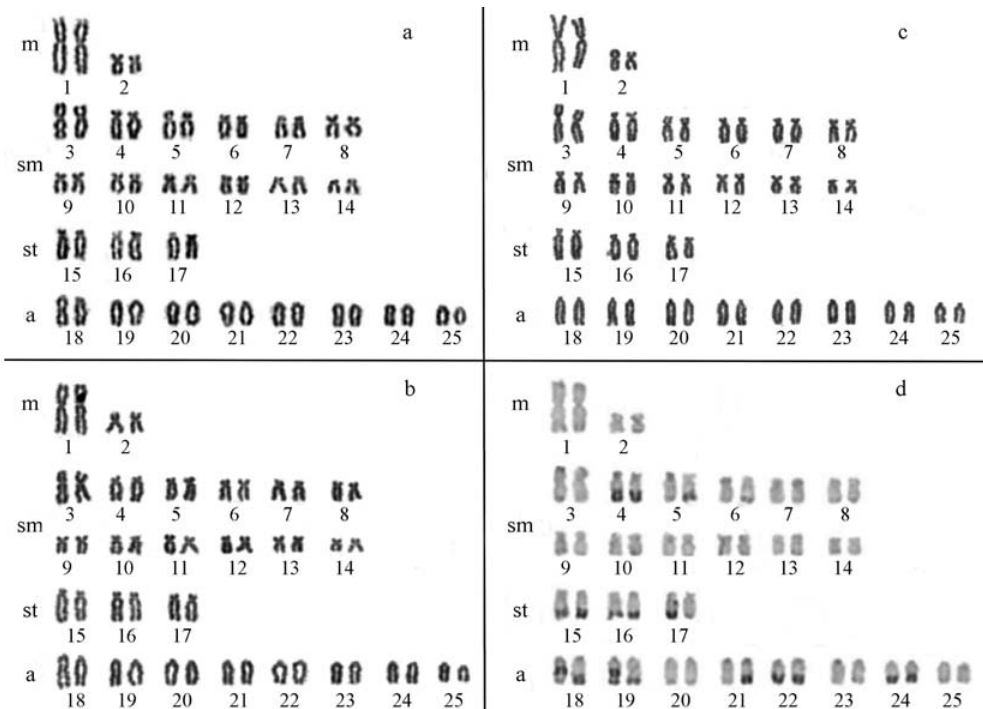
Figure 1 - Karyotypes of Astyanax sp.D. Giemsa staining of specimens collected in the Bicudo (a) and Poço Claro (b) Rivers and in the nameless stream from the left bank of the Iguaçu River basin (c). General C-banding pattern